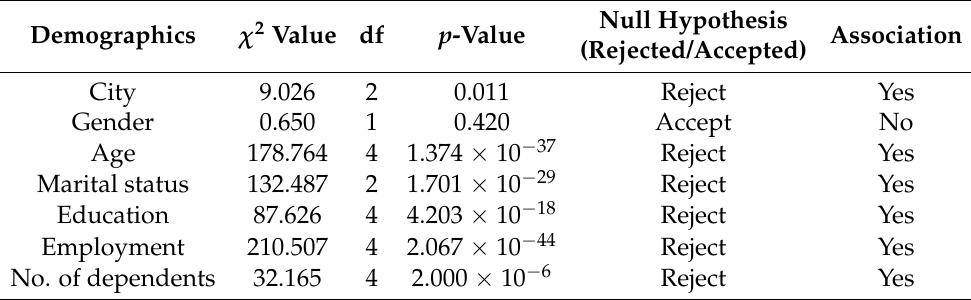
Table 1. Results of χ 2 test between demographic factors and buying behaviour of buyers/non-buyers of a life insurance policy.